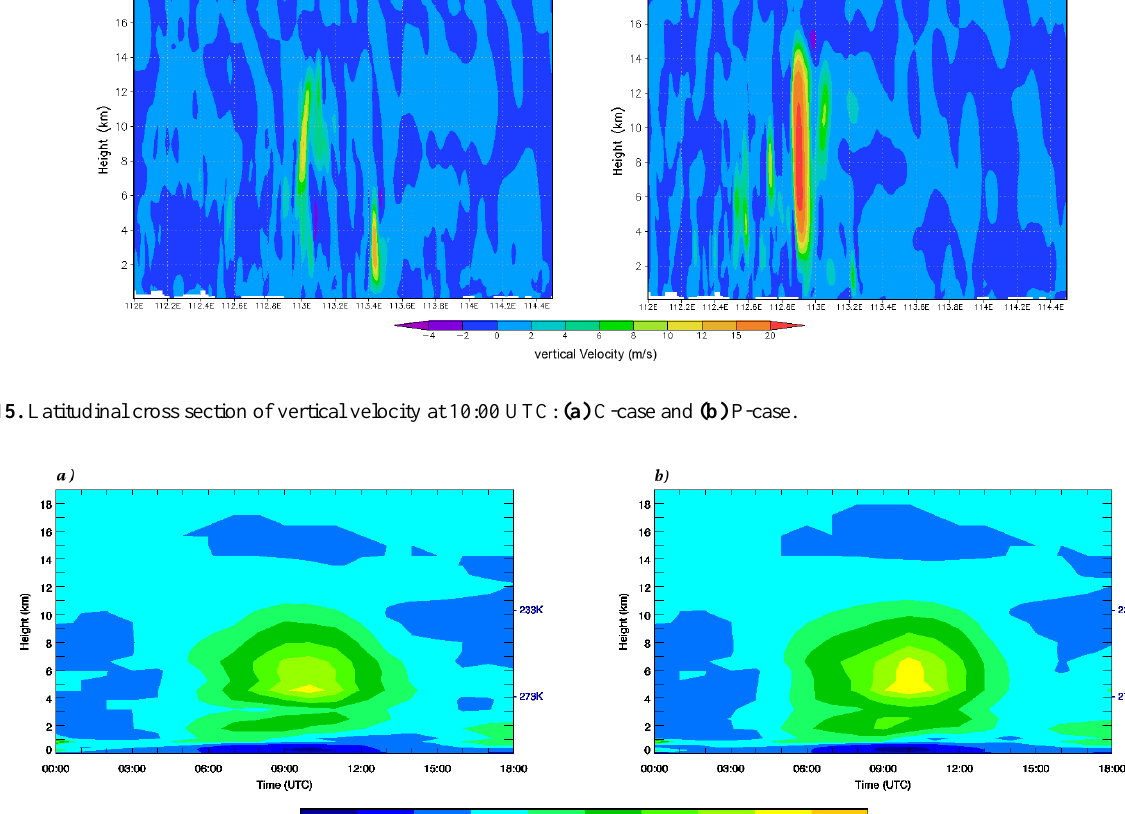
Fig. 16. Temporal evolution of latent heat profiles: (a) C-case and (b)